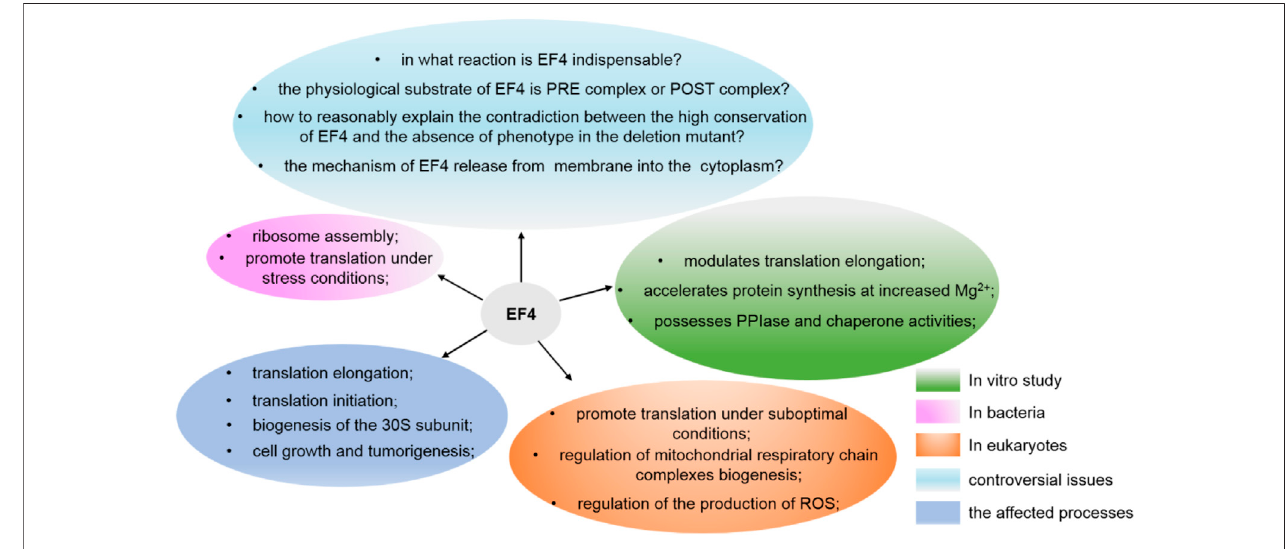
FIGURE 5 | Various functions of EF4 and the issues still need to be